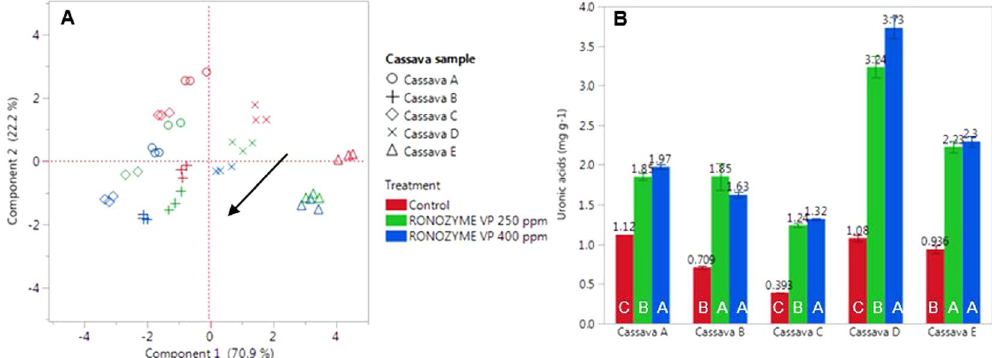
Figure 1. Cassava cell wall monosaccharide composition and solubilization by enzyme. (A) PCA plot of neutral sugars in the insoluble NSP fraction of cassava samples (A–E) before and after treatment with NSPase at 250 or 400 ppm. ( B) Soluble uronic acids quantified by HPIC in cassava samples (A–E) before (red bars) and after treatment with NSPase at 250 (green bars) or 400 ppm (blue bars). Different capital letters within each cassava sample in the graph indicate statistical differences between enzyme treatments (Tukey-Kramer P < 0.05).